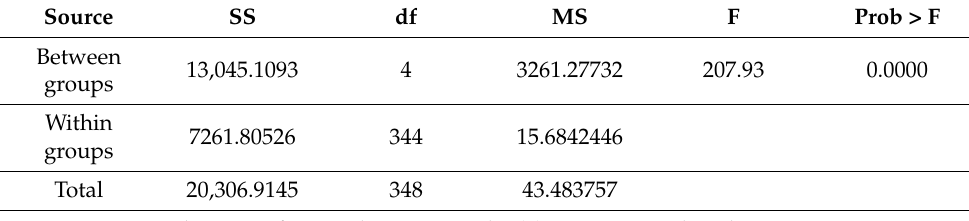
Table 5. Analysis of variance.